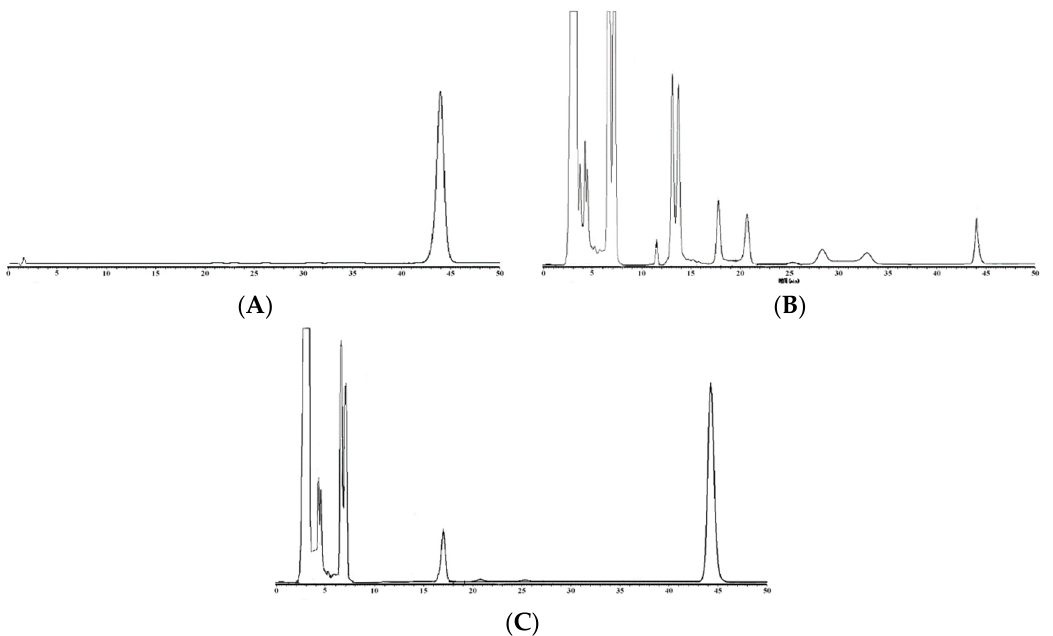
Figure 2. HPLC chromatograms of CEP ( A ) crude extracts ( B ) and total alkaloids ( C ) from S. cepharantha Hayata marked in star-shaped.